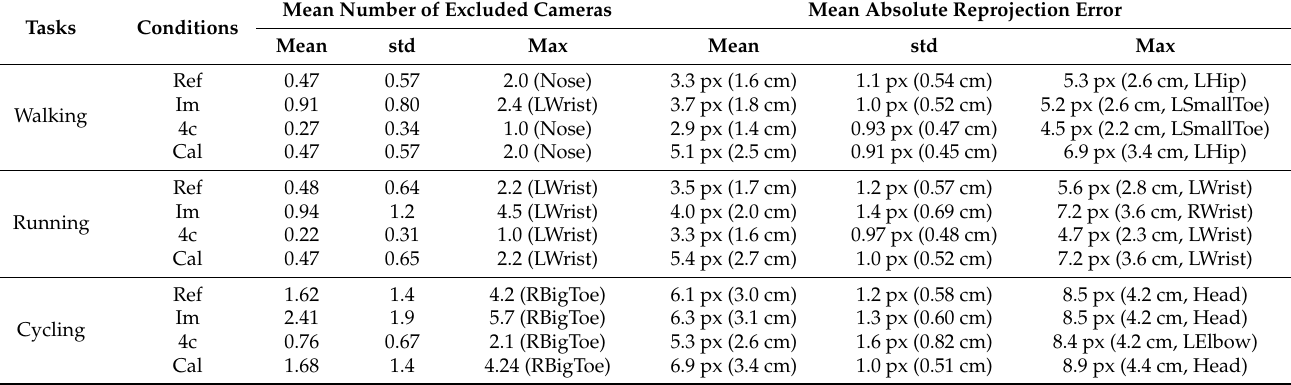
Table 1. Descriptive statistics on the triangulation step performed by Pose2Sim from OpenPose body_25b model. Mean absolute reprojection error and mean number of excluded cameras were calculated over time. Mean (mean), standard deviation (std), and maximum (max) in each of these variables are displayed. Walking, running, and cycling tasks were investigated in each four conditions: reference (Ref), poor image quality (Im), four cameras instead of eight (4c), and calibration errors (Cal).